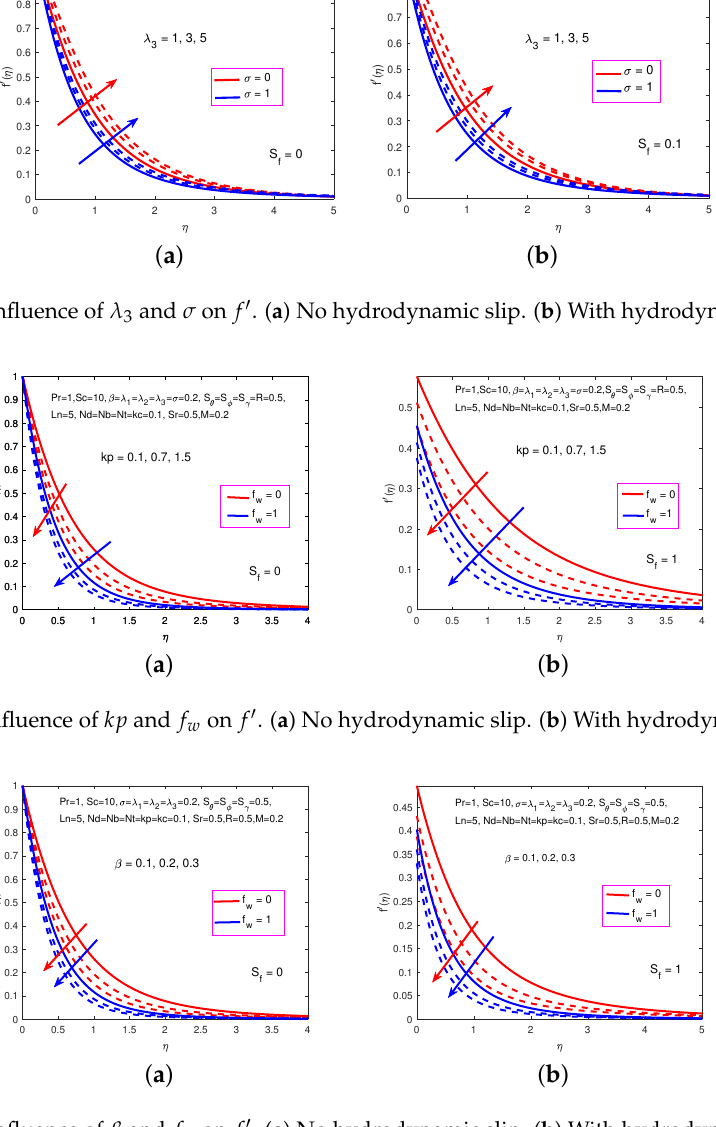
Figure 7. Influence of β and f w on f (cid:48) . ( a ) No hydrodynamic slip. ( b ) With hydrodynamic